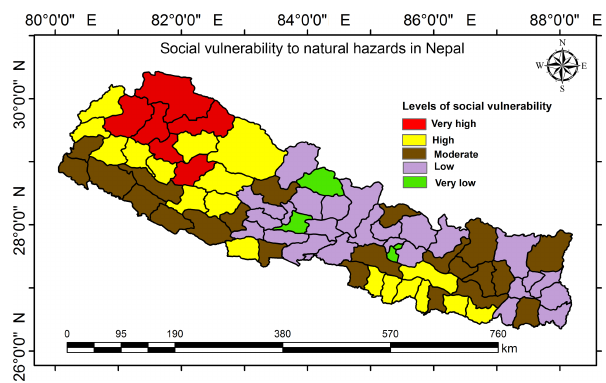
Figure 4. District-wide social vulnerability to natural hazards in